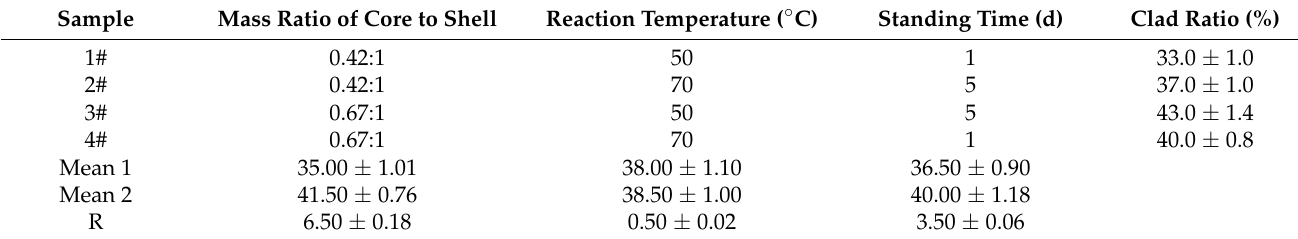
Table 6. Range results of microcapsule clad ratio by the orthogonal test.